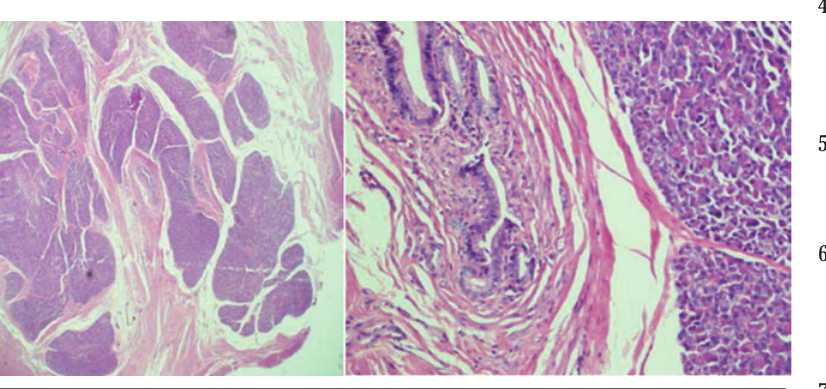
Figure 2. Cystic lesion under umbilicus with solid vascular component.